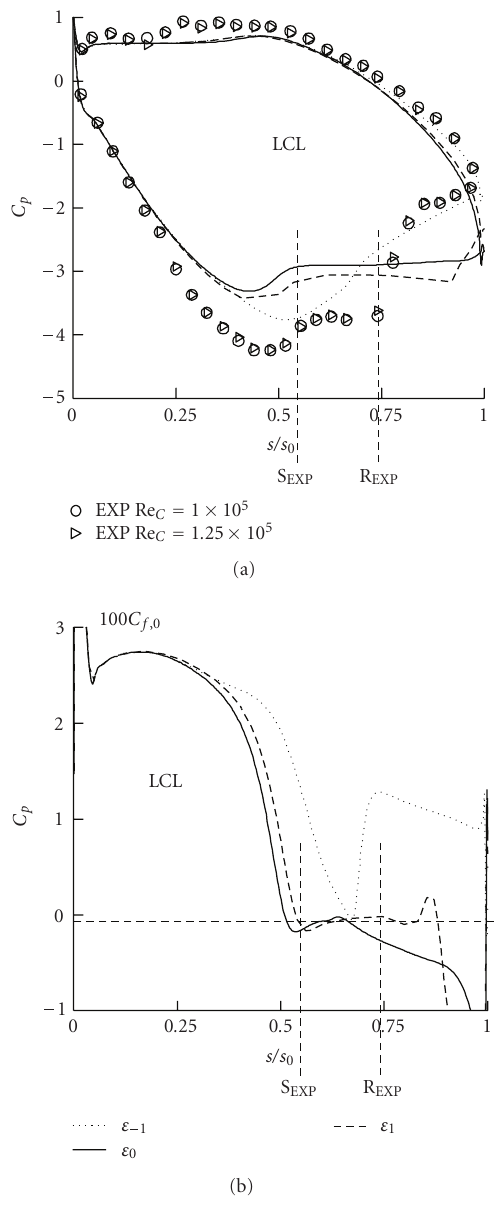
Figure 5: Pressure coe ffi cient and wall shear stress coe ffi cient on the suction side for di ff erent inlet values of ε for the undisturbed